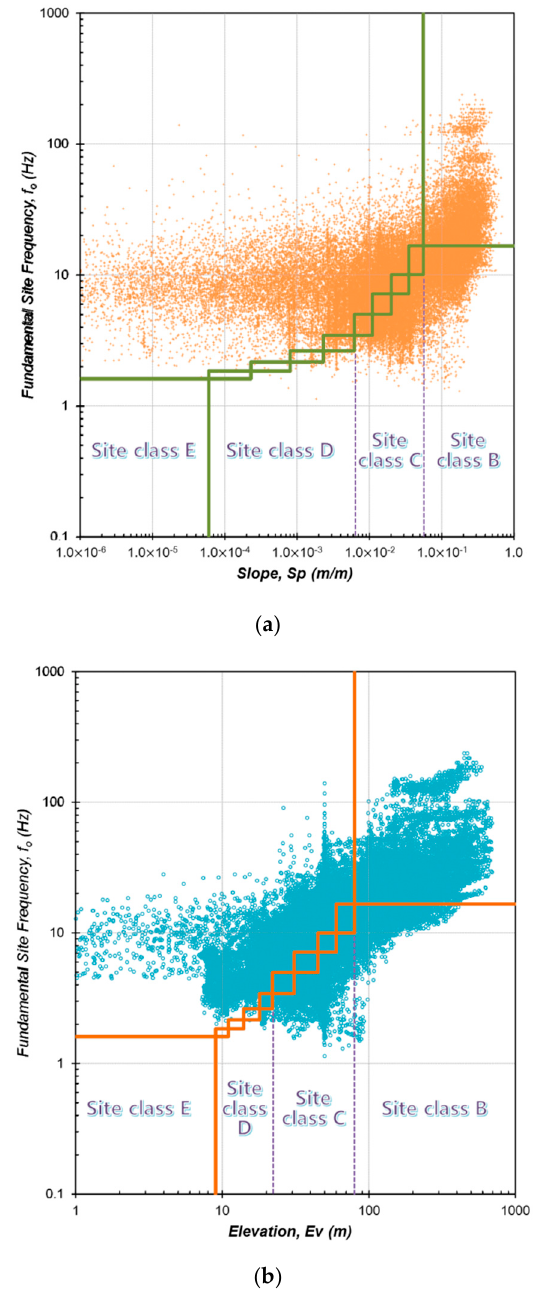
Figure 9. Geo-proxy-based empirical classification for each site classification subdivision according to f 0 ( T G ) in Seoul: ( a ) surface terrain slope; ( b ) surface elevation. f 0 ( T G ) in Seoul: ( a ) surface terrain slope; ( b ) surface